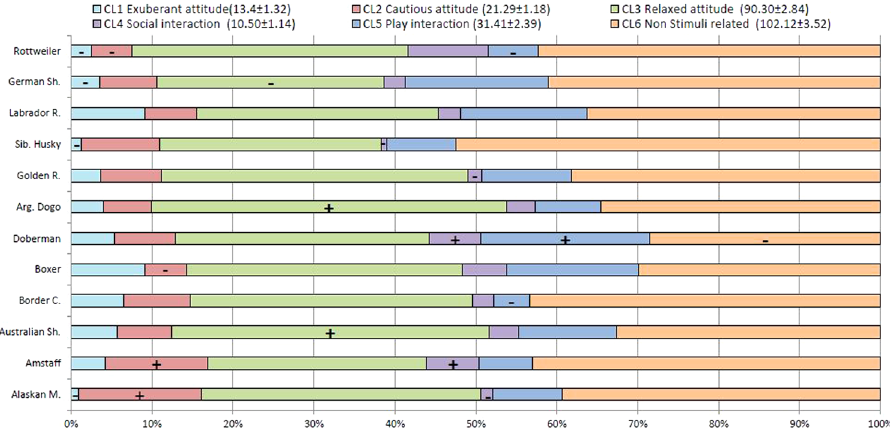
Figure 2. Breed behavioural profiles. Bars show the proportion of expression of the six personality traits for each breed. Legend : in brackets the population mean ± SEM for each personality traits. Minus and plus inside bars indicate values that are significantly below or above the population mean respectively ( α ≤ 0.05). For each trait, mean values and statistics are available in Table